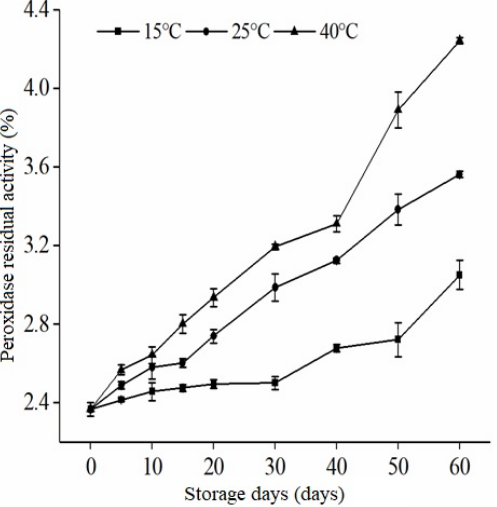
Figure 2. Effect of Storage Temperature on Residual Peroxidase Activity in Extruded Rice Bran.